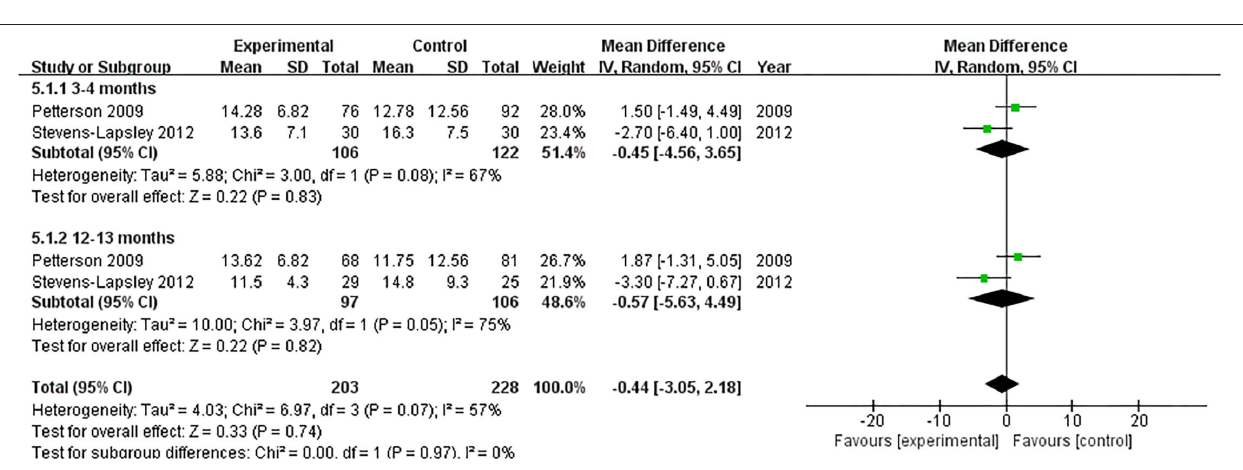
FIGURE 9 | Forest plots of meta-analysis of the effect of NMES vs. conventional rehabilitation on stair-climbing test.